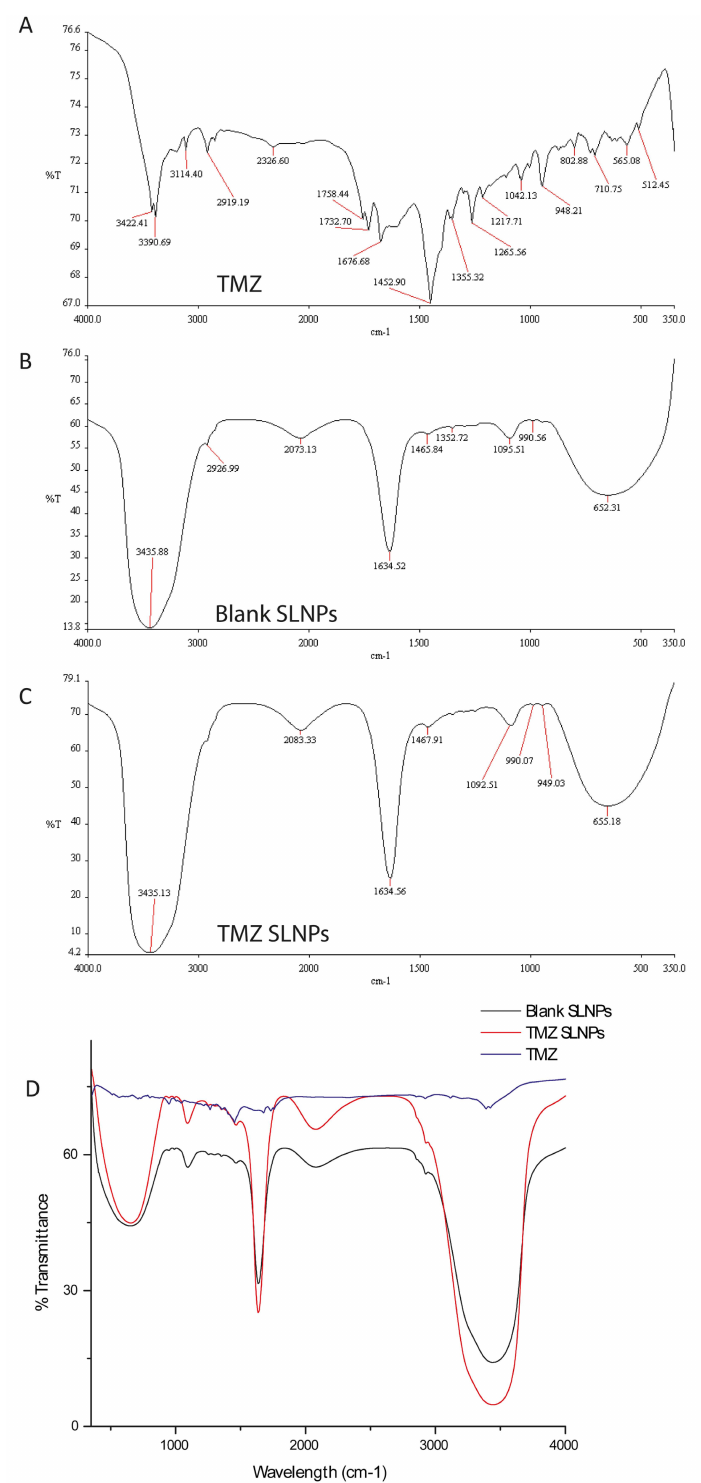
Figure 5. Fourier transform infrared spectroscopy (FTIR) spectra ( A ) TMZ. ( B ) Blank-SLNPs and ( C ) SLNP-TMZ, ( D ) Collective spectra of three plotted via Origin 8.0. The infrared spectra had strong absorption peaks, at 1600 cm − 1 and 3500 cm − 1, that are C-C and N-H bonds in the case of SLNP-TMZ, which are stretching vibration peaks due to the conjugation of TMZ with SLNPs via coupling